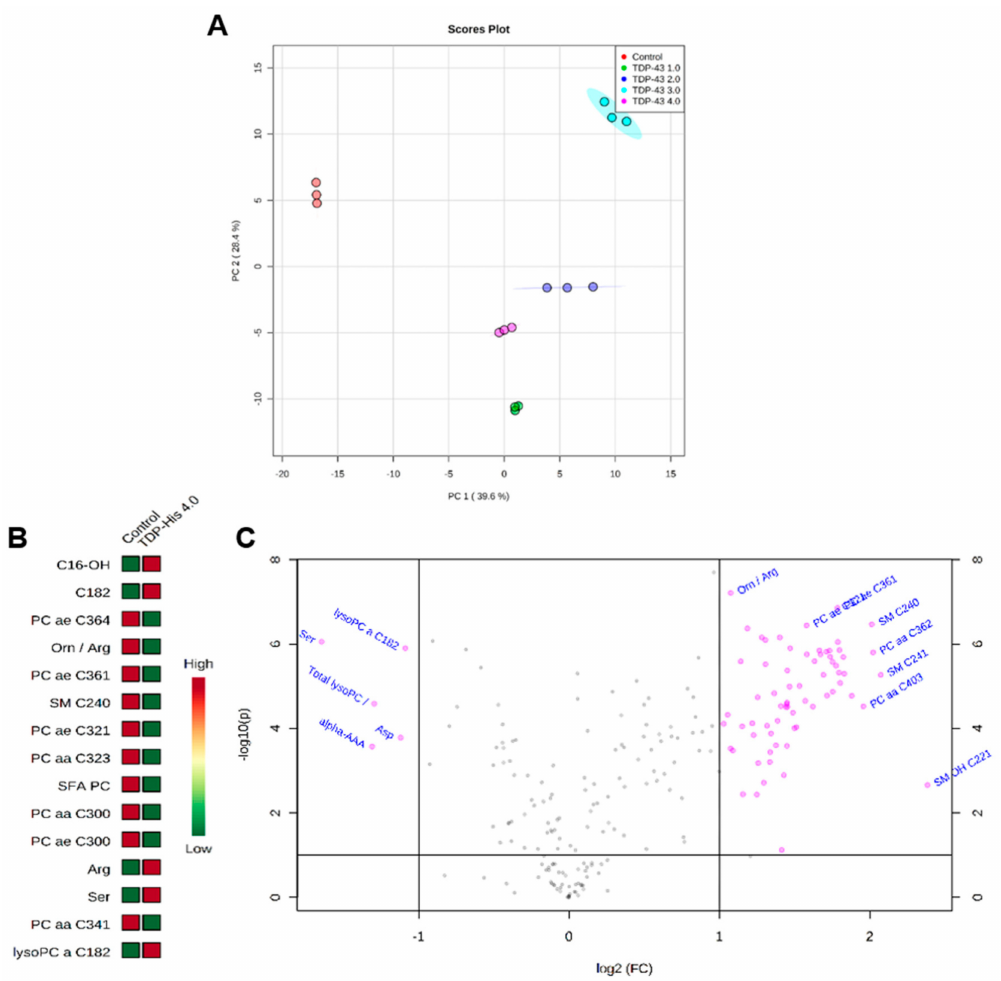
Figure 6. ( A ) Metabolomics analyses reveal a set of distinguishable metabolites altered in TDP-43-overexpressing HEK293T cells. ( B , C ) VIP metabolites and volcano plot analysis are represented for TDP-43 4 µ g. Metabolomics analyses were realized with MetaboAnalyst (http: //